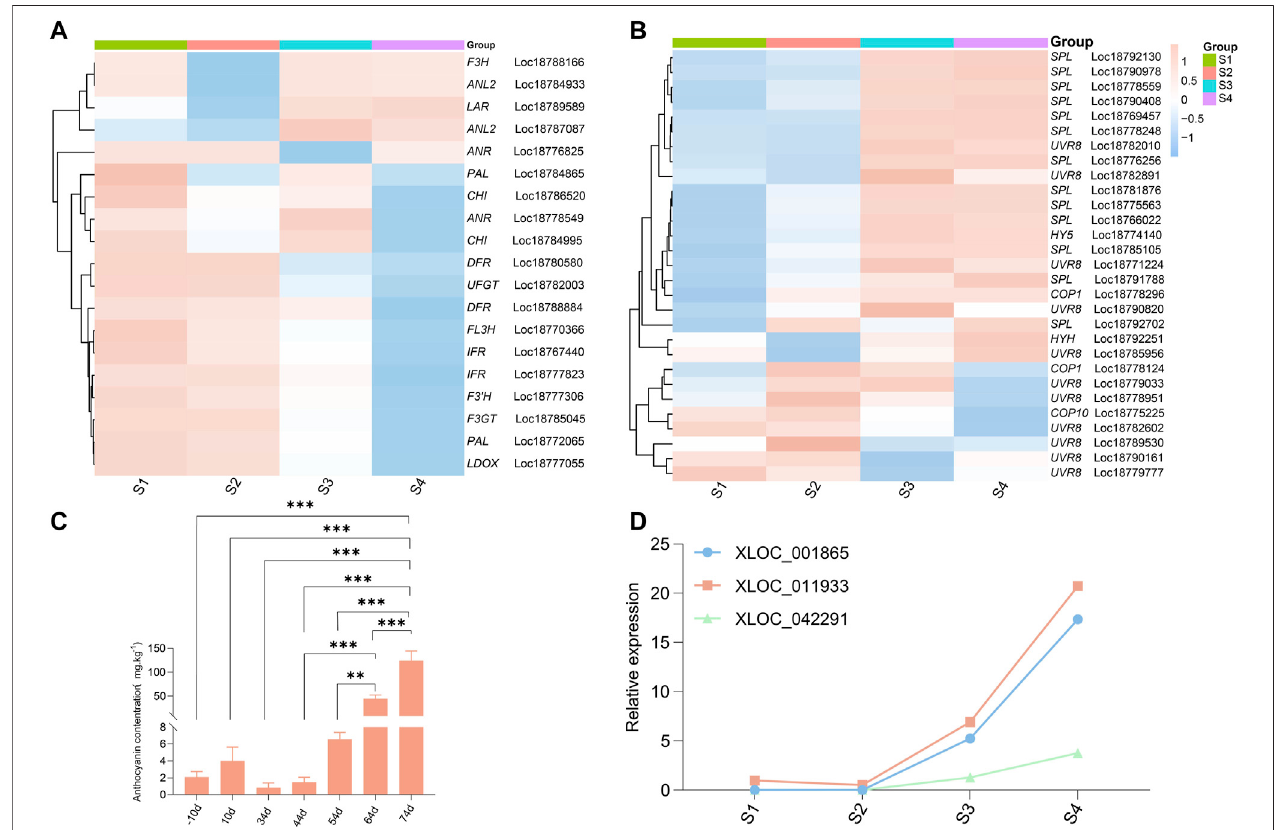
FIGURE 5 | Heatmap and graphical presentations of selected genes during fruit development stages. (A) Expression pro fi les of structural genes involved in the anthocyanin biosynthesis pathway. The color gradient with eight different colors from blue to red corresponds to transcript levels from low to high, with the values representing the log2 (FPKM) values. (B) Expression pro fi les of genes related to UV-light-mediated anthocyanin biosynthesis. The color key at the top of the heatmap represents the relative color scheme of the FPKM values. (C) Anthocyanin content in different development stages. (D) Graphical representations of XLOC_011933, XLOC_001865, and XLOC_042291 related to anthocyanin biosynthesis based on RNA-seq values in blood- fl eshed